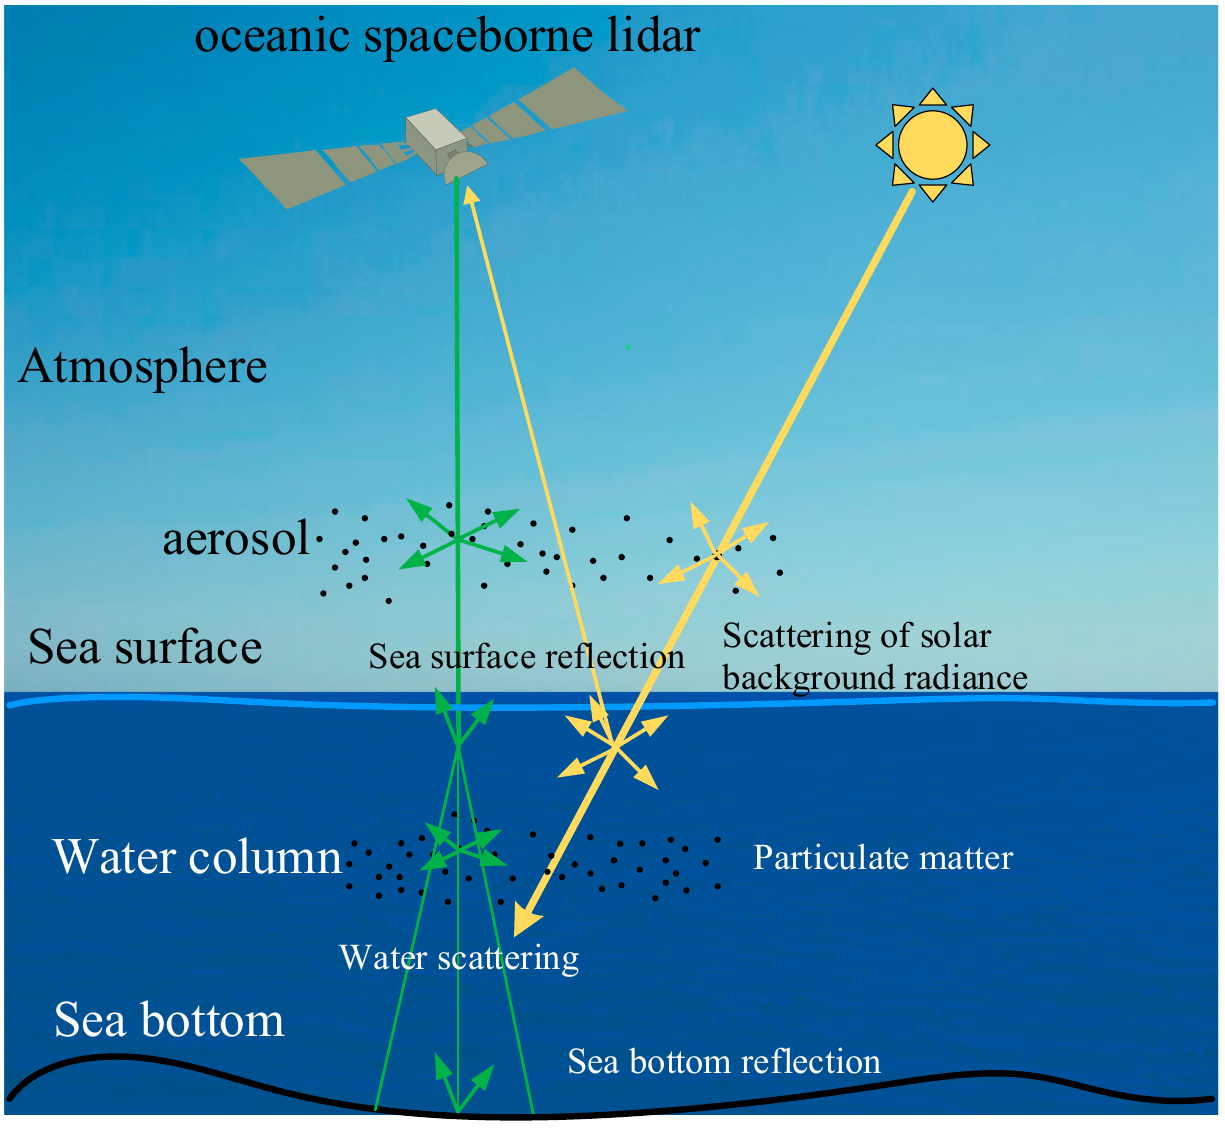
Figure 1. Schematic of oceanic spaceborne lidar.